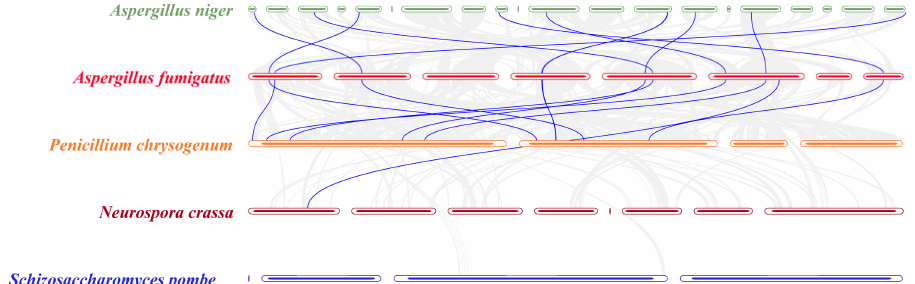
Figure 4. Collinearity analysis of the SET-domain genes from five species. A total of 13 SET-domain genes derived from A. fumigatus (AFUA_1G03000, AFUA_1G11090, AFUA_2G08510, AFUA_2G08775, AFUA_2G10080, AFUA_3G06400, AFUA_3G06480, AFUA_4G09180, AFUA_5G06000, AFUA_5G12710, AFUA_6G04520, AFUA_6G06335, and AFUA_7G04410) to show the collinearity relationships with the orthologous from other four species. These 13 SET-domain genes were distributed into all the three clusters from Figure 2. The gray lines indicate gene blocks in A. fumigatus that are orthologous to the other genomes. The blue lines delineate the syntenic SET-domain gene